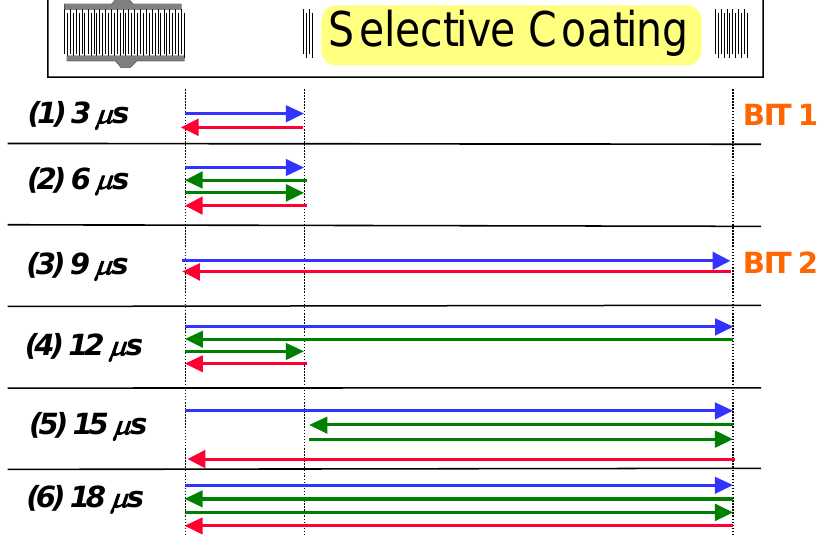
Figure 5. Surface wave reflections leading to the response pattern in Figure